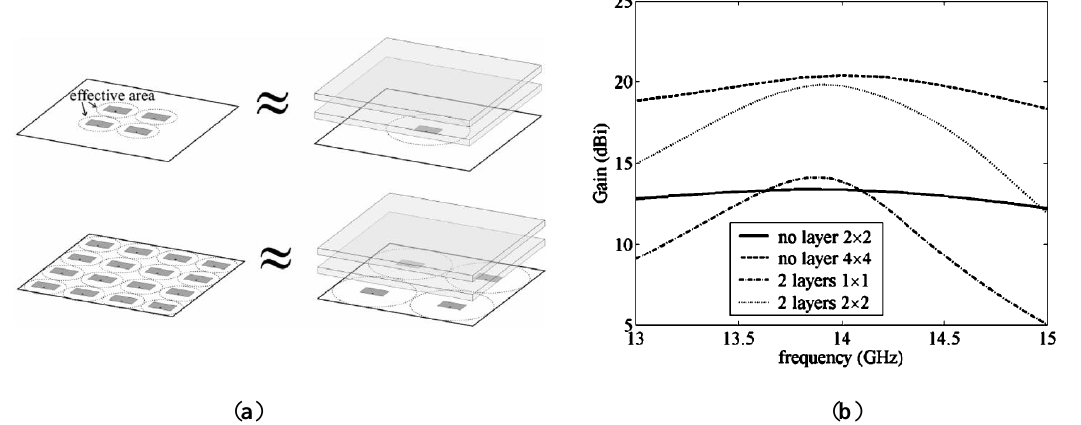
Figure 9. RCA with an array source radiator: ( a ) Schematic configuration; ( b ) Gain of the antenna